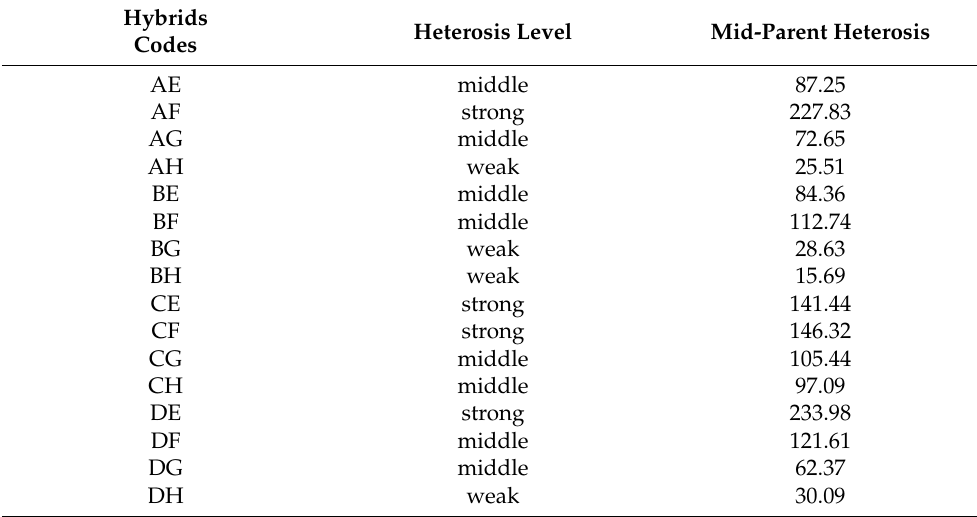
Table 4. Mid-parent heterosis value analysis of plant gross weight in